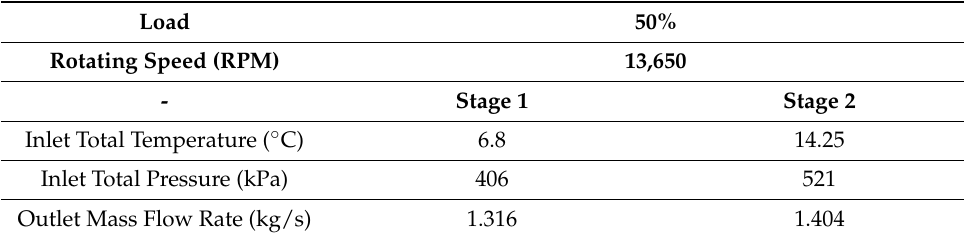
Table 7. Boundary conditions for two-stage IPLV load 50%.